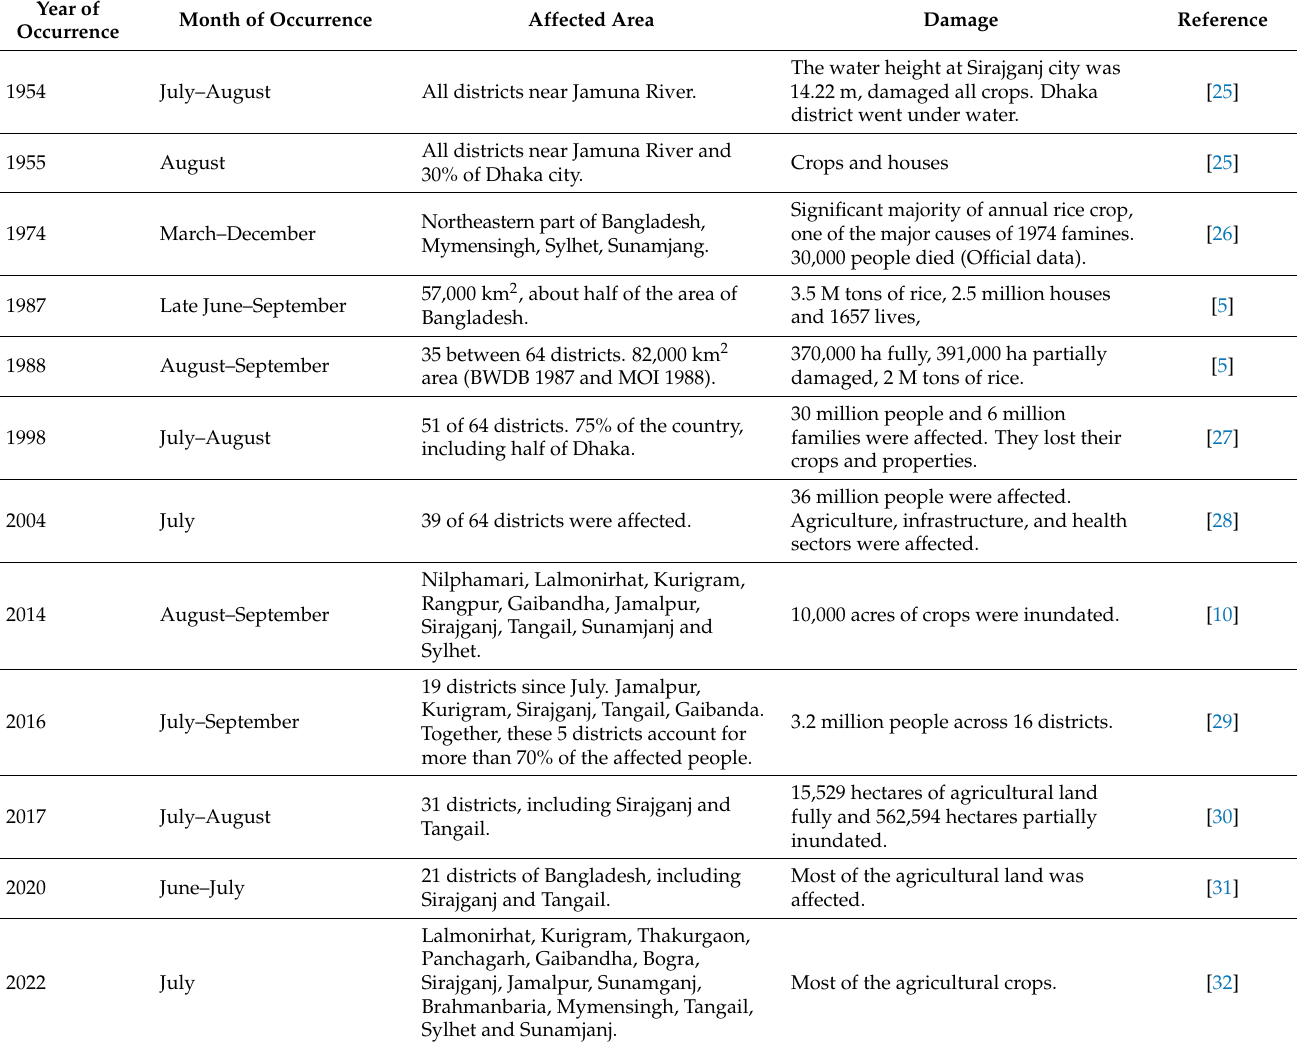
Table 1. Major flood events in Bangladesh from 1954 to